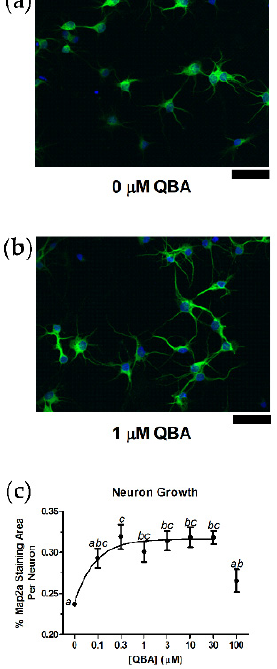
Figure 1. Queen bee acid (QBA) increased hippocampal neuron growth. The extent of growth was assessed by dividing the percent area of the Map2a fluorescence (green) by the number of neuronal nuclei identified by the DAPI signal (blue). ( a ) Control neurons were qualitatively smaller and less connected than neurons provided QBA (1 µ M) for seven days ( b ). ( c ) Concentration-response curve for QBA effects on neuron growth. Lack of shared superscripts indicates data points that differed significantly ( p < 0.05) in Tukey’s post hoc test. N = 5–6 in triplicate over two separate culture runs. Error bars represent the standard error of the mean (SEM). Scale bars = 50 µ